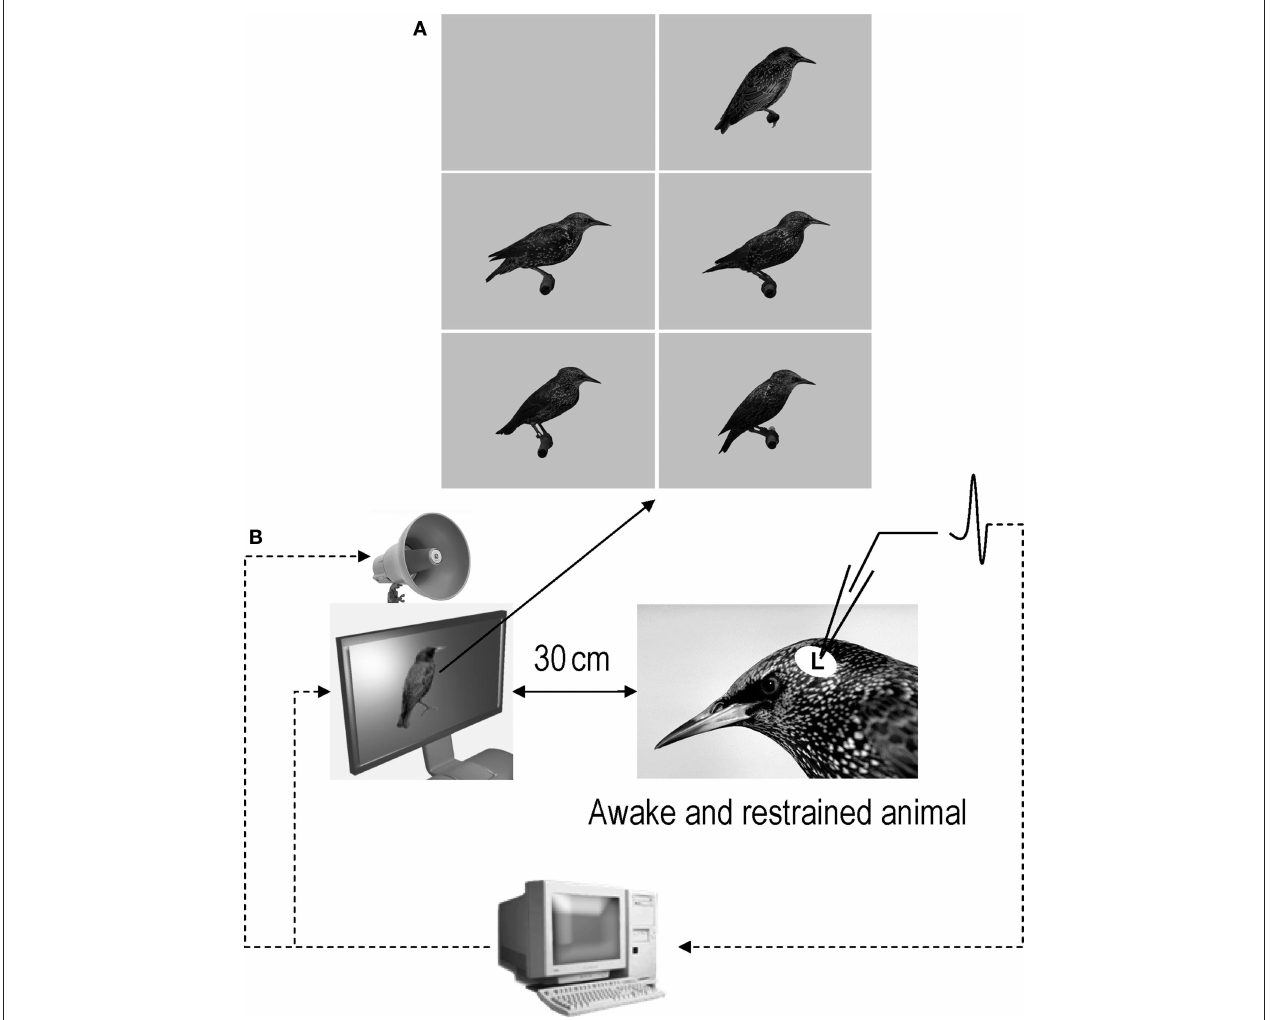
unfamiliar bird (© 1996–2010 www.oiseaux.net, Marcel Van der Tol) and the four other images are images of four of the five birds used in this study. Although images appear here in grayscale, they were displayed in colors during the experiments. (B) Schematic representation of the recording